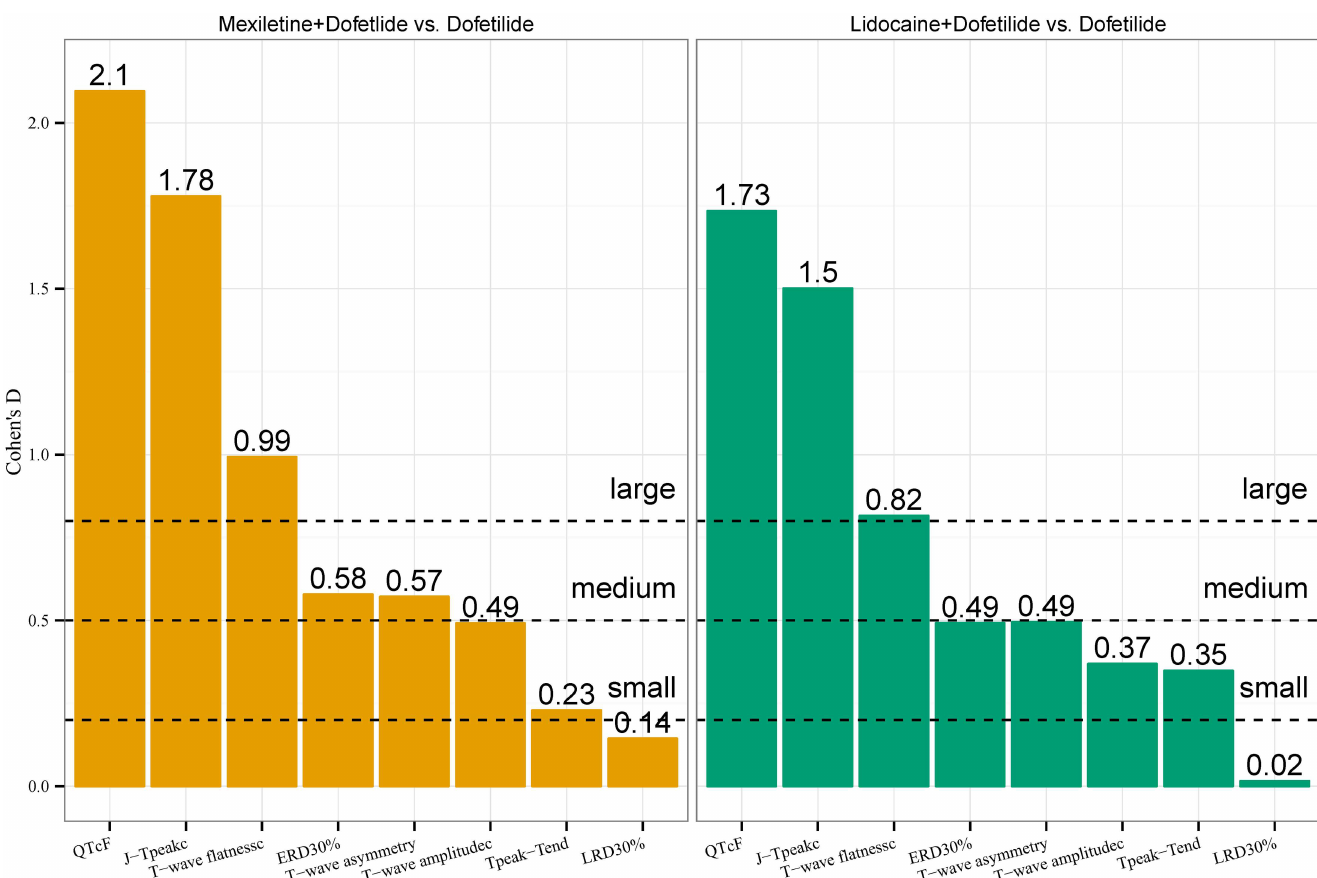
Fig 3. Cohen’s d effect size for each ECG biomarker. Cohen’sd effect size for each ECG biomarker for mexiletine+ dofetilideand lidocaine + dofetilidevs.